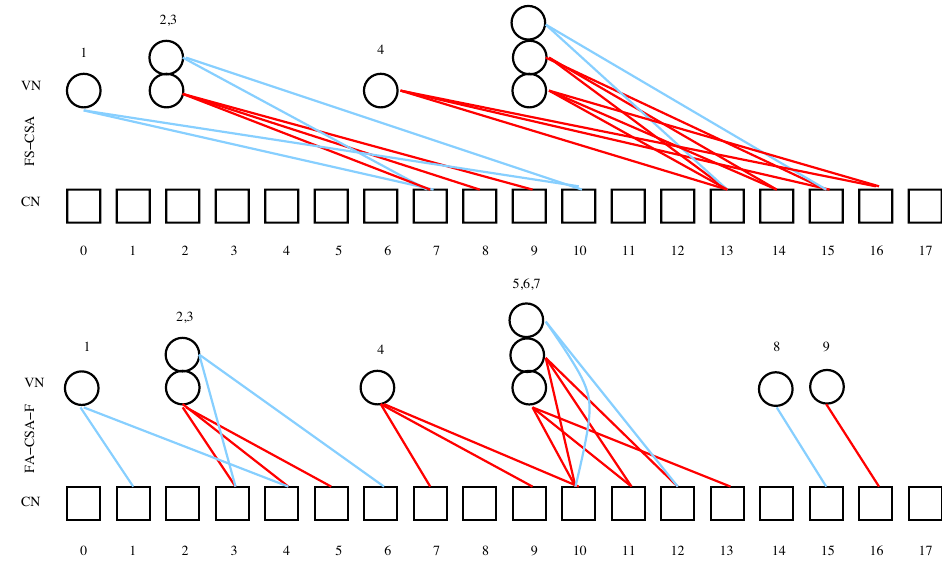
Figure 2. Equivalent graph representation of the system depicted in Figure 1.